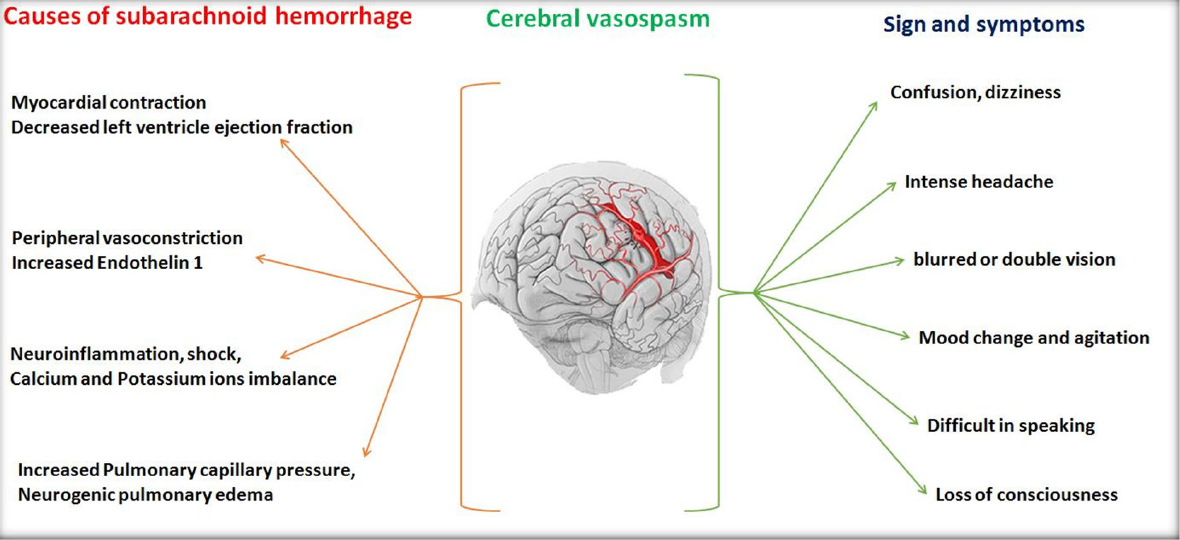
Figure 4. Various causes and symptoms of cerebral vasospasm.